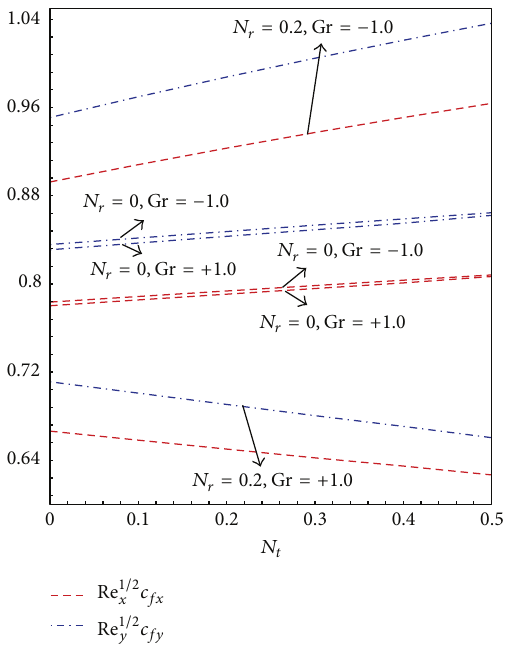
Figure 4: Graphs of skin friction coefficient along 𝑥 - and 𝑦 - direction for 𝑁 𝑏 = 0.2 and varying 𝑁 𝑡 .